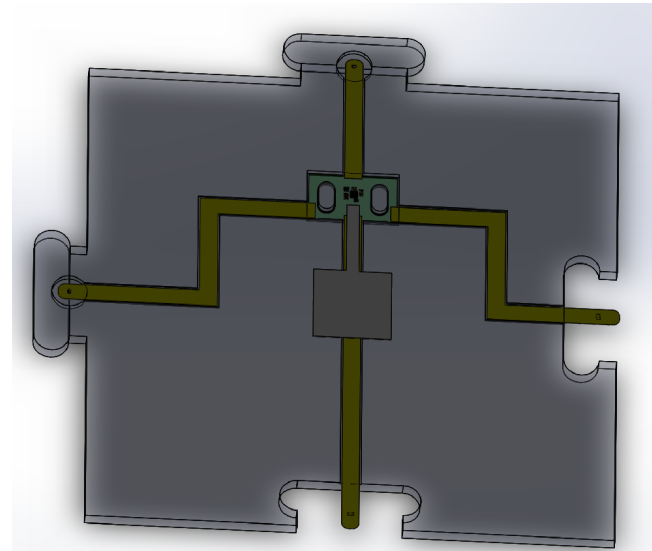
Figure 2. Bottom side of the foam